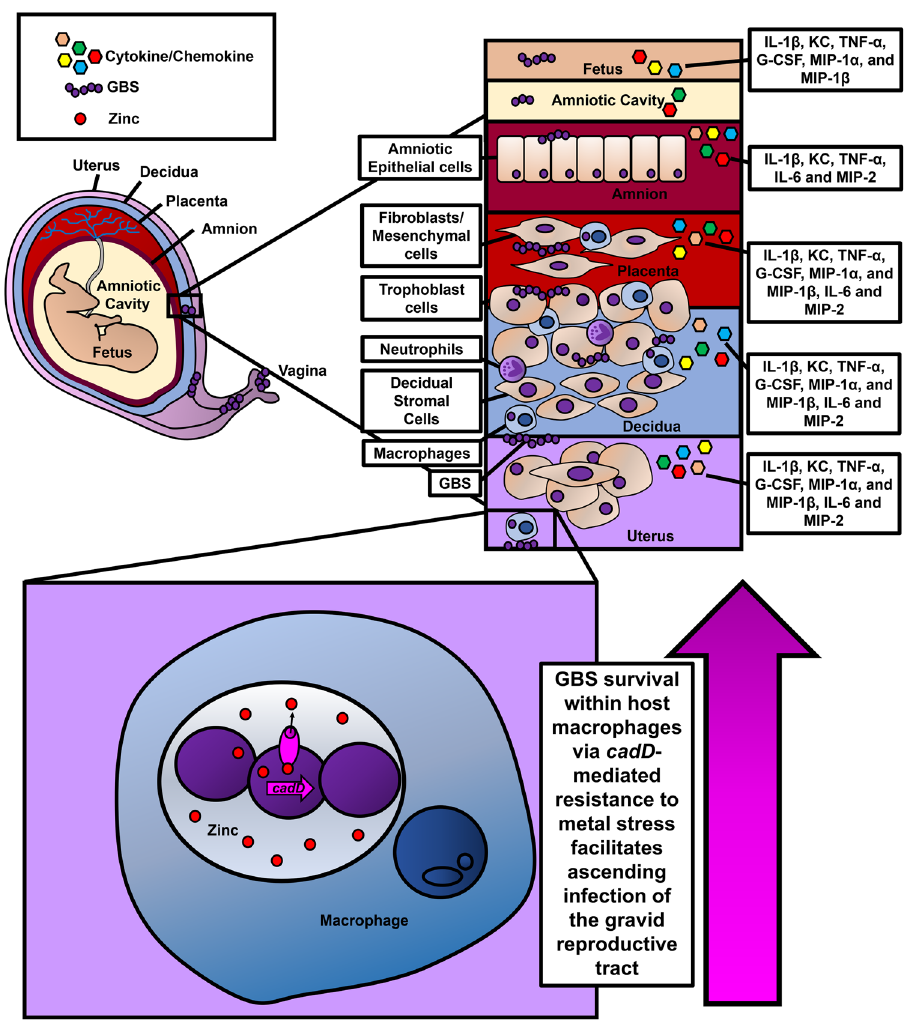
Fig. 7 | Conceptual model of the role of cadD in GBS pathogenesis. GBS infects the gravid reproductive tract and encounters sentinel innate immune cells such as macrophages withinthe tissues.Macrophages can performphagocytosistoengulf GBS which deploys enhanced expression of cadD within the phagosome to over- come divalent cation stress, including zinc intoxication, to turn the macrophage